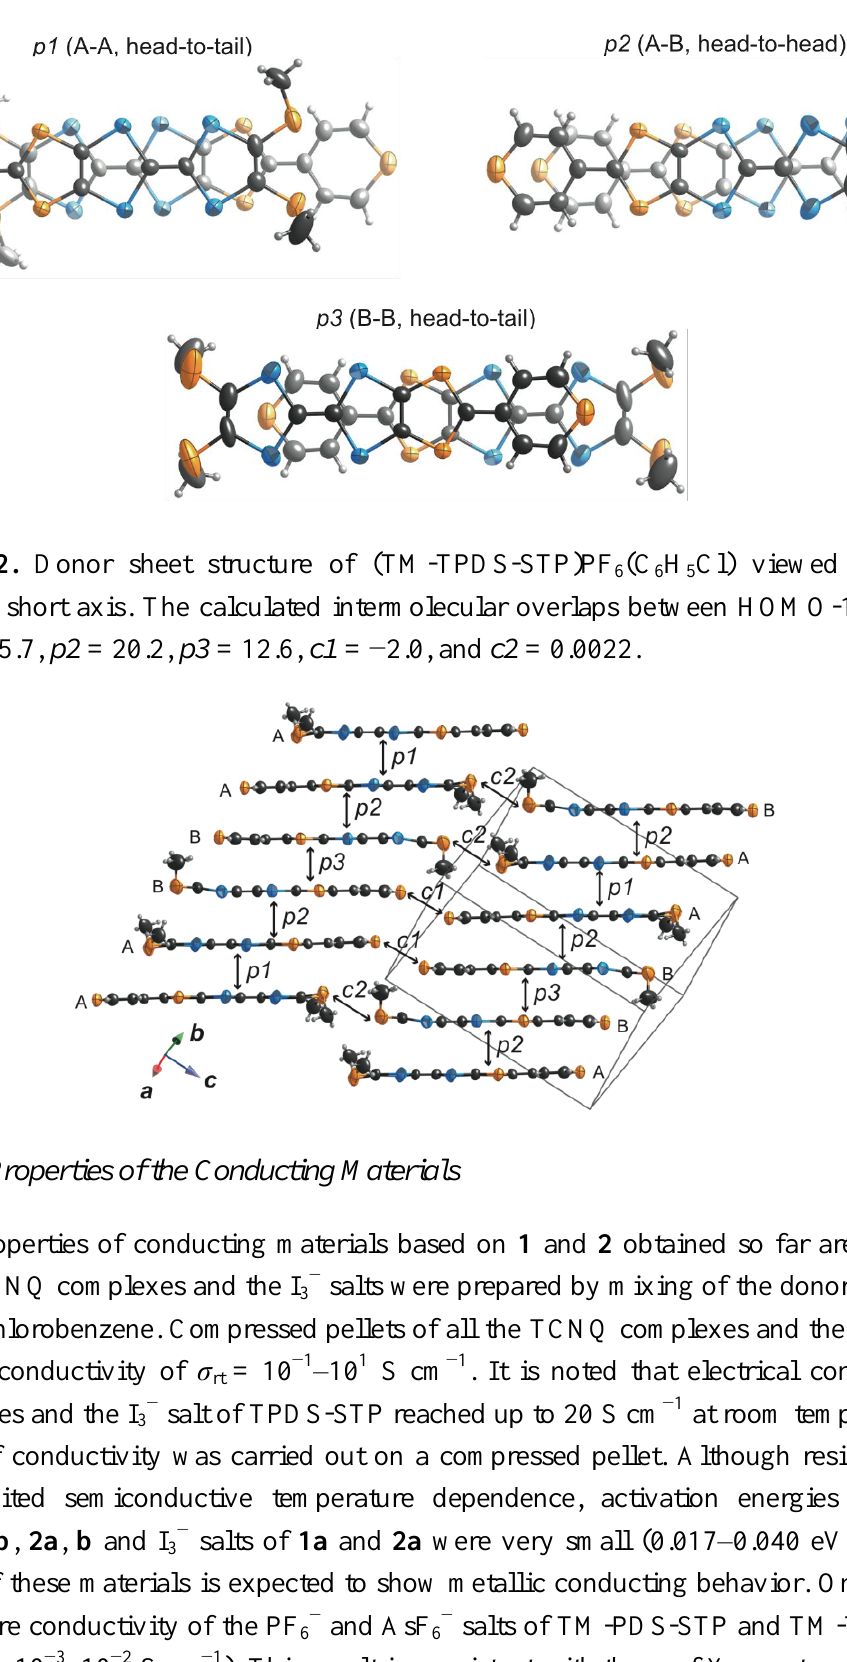
Figure 11. Molecular overlap modes for p1 , p2 , and p3 of (TM-TPDS-STP)PF The atoms and bonds of the depth molecules are faded out.